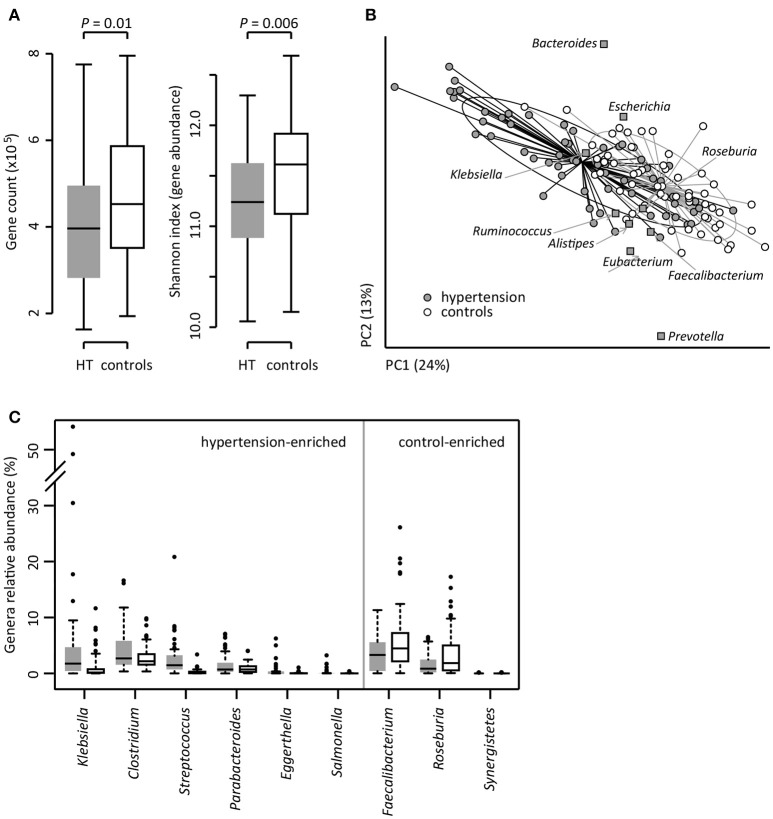
Difference of gut microbial community between hypertensive patients and controls. (A), Difference of alpha diversity between hypertensive (HT) patients and controls. (B), dbRDA based on the Bray-Curtis distances between microbial genera, revealing a hypertensive microbial dysbiosis which overlaps only in part with taxonomic composition in patients and controls. The first two principle components and the ratio of variance contributed is shown. Genera (square) as the main contributors are plotted by their loadings in these two components. Lines connect samples in the same group, and circles cover samples near the center of gravity for each group. (C), Boxplot shows the significantly different genera between patients and controls. Genera with q < 0.05 (Mann-Whitney U-test corrected by FDR) are shown. Only the genera with average relative abundances greater than 0.05% of total abundance in all samples are shown for clarity. Gray and white boxes represent the patients and controls, respectively. For A and C, the boxes represent the interquartile range (IQR) between first and third quartiles and the line inside represents the median. The whiskers denote the lowest and highest values within 1.5 times IQR from the first and third quartiles, respectively. The dots represent outliers beyond the whiskers.